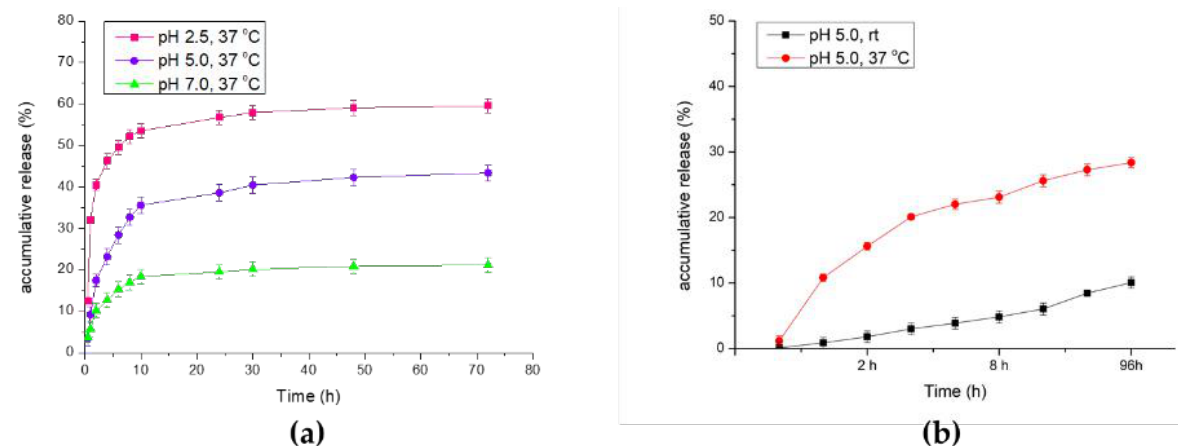
Figure 6. In vitro drug releasing efficacy analysis through UV–Vis analysis. ( a ) Comparison of accumulative release rate under different pH values. ( b ) Comparison of accumulative release rate at different temperatures.